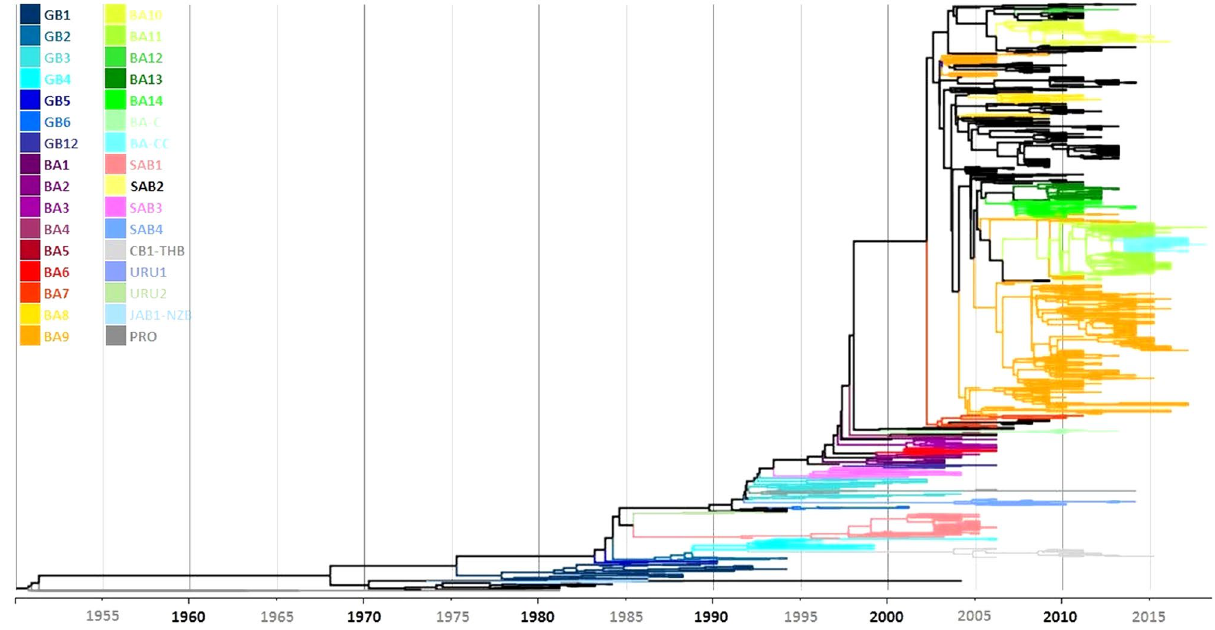
Figure 1. Phylogenetic tree of 1,334 unique RSV-B complete G gene ectodomain sequences constructed by Bayesian MCMC analysis. Genotype assignment was carried out with the use of 169 reference sequences including 37 previously described genotypes and prototype